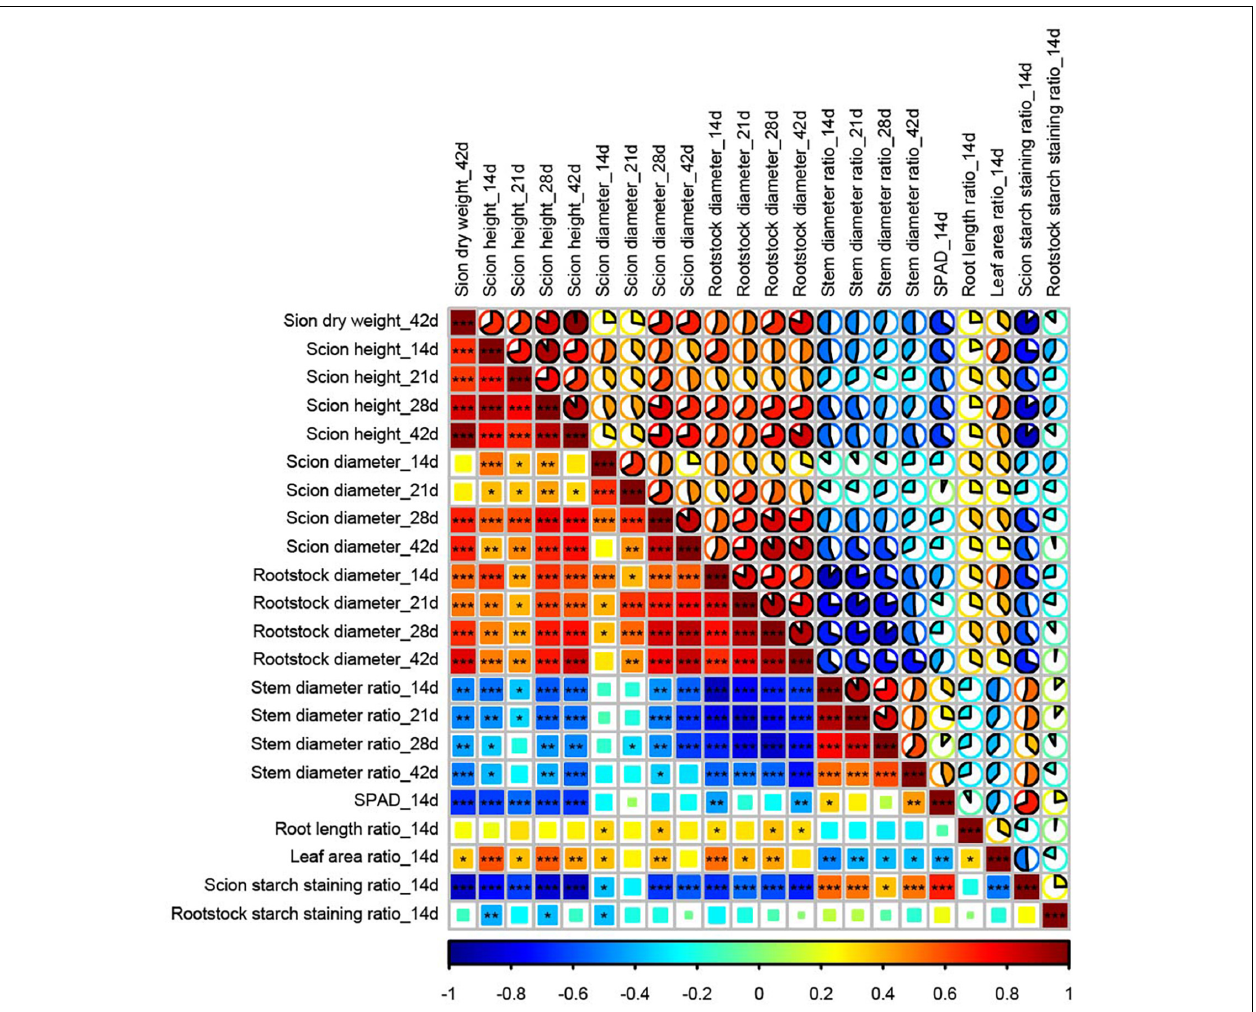
FIGURE 6 | Correlation analysis between parameters in melon grafted onto eight Cucurbitaceae rootstocks. Stem diameter ratio: stem diameter above 5 mm of the graft junction/stem diameter below 5 mm of the graft junction. Root length ratio: root length of melon hetero-grafted plants/root length of their rootstock homo-grafted plants. Leaf area ratio: scion leaf area of melon hetero-grafted plants/melon homo-grafted plants. Scion starch staining ratio: starch–iodine staining area/area of transected scion stem above 2 mm of the graft junction. Rootstock starch staining ratio: starch–iodine staining area/area of transected rootstock stem below 2 mm of the graft junction. Different colors, square size, and pie size indicate Pearson’s correlation coefficient. Asterisks indicate significant correlation between two parameters (* p < 0.05, ** p < 0.01, *** p <